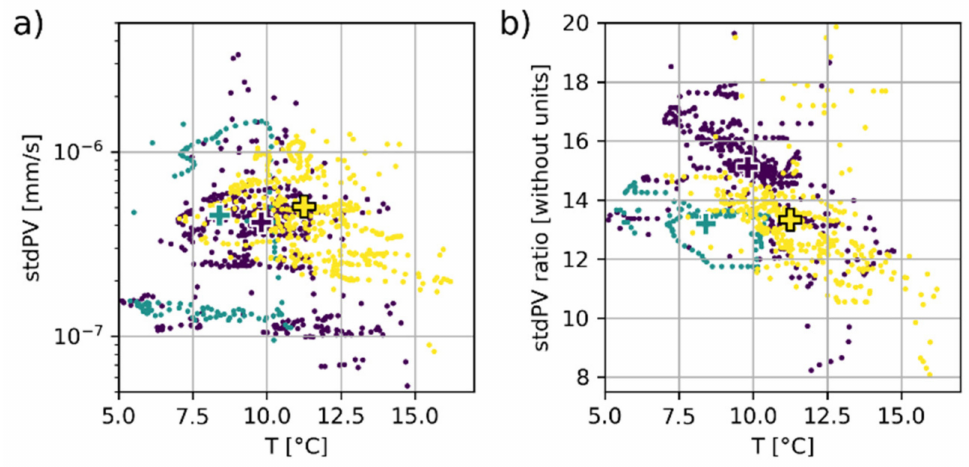
Figure A3. ( a ) PV standard deviation (stdPV) on BOECA in 8–12 Hz frequency band as a function of air temperature; ( b ) corresponding stdPV ratio between BOECA and BOREF. Initial stage before bolting is shown with dark blue dots. Stage between i 1 and i 2 is shown in green. Final stage after i 2 is shown with yellow dots. Centroid of each phase is pointed with a colored cross. Days with drilling works have been removed from the